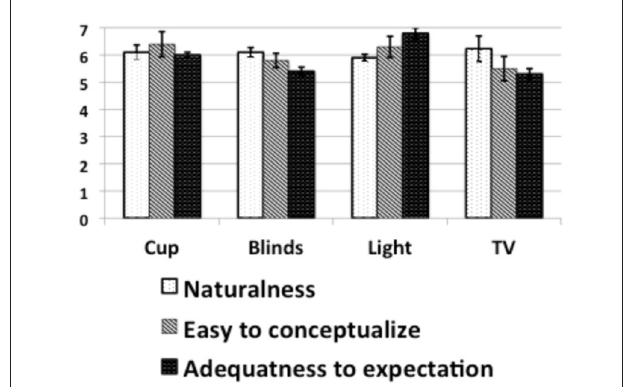
FIGURE 7 | Averaged answers given by users about the naturalness of the action, the easiness of conceptualization and the adequateness to expectation on a scale from 1 to 7. The error bars are the 95% confidence